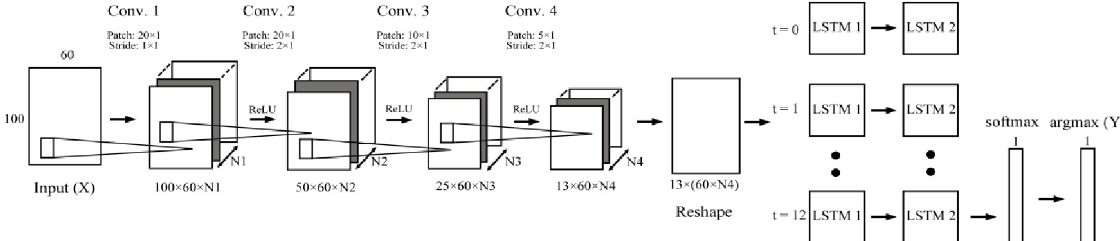
Fig 2. DeepConvLSTM architecture. ConvNet-LSTM architecture. N1, N2, N3, and N4 represent the numbers of channels (also called feature map) created after each convolutional layer. Their values are respectively 16, 16, 32 and 64. ReLU (rectified linear unit) represent the activation function.